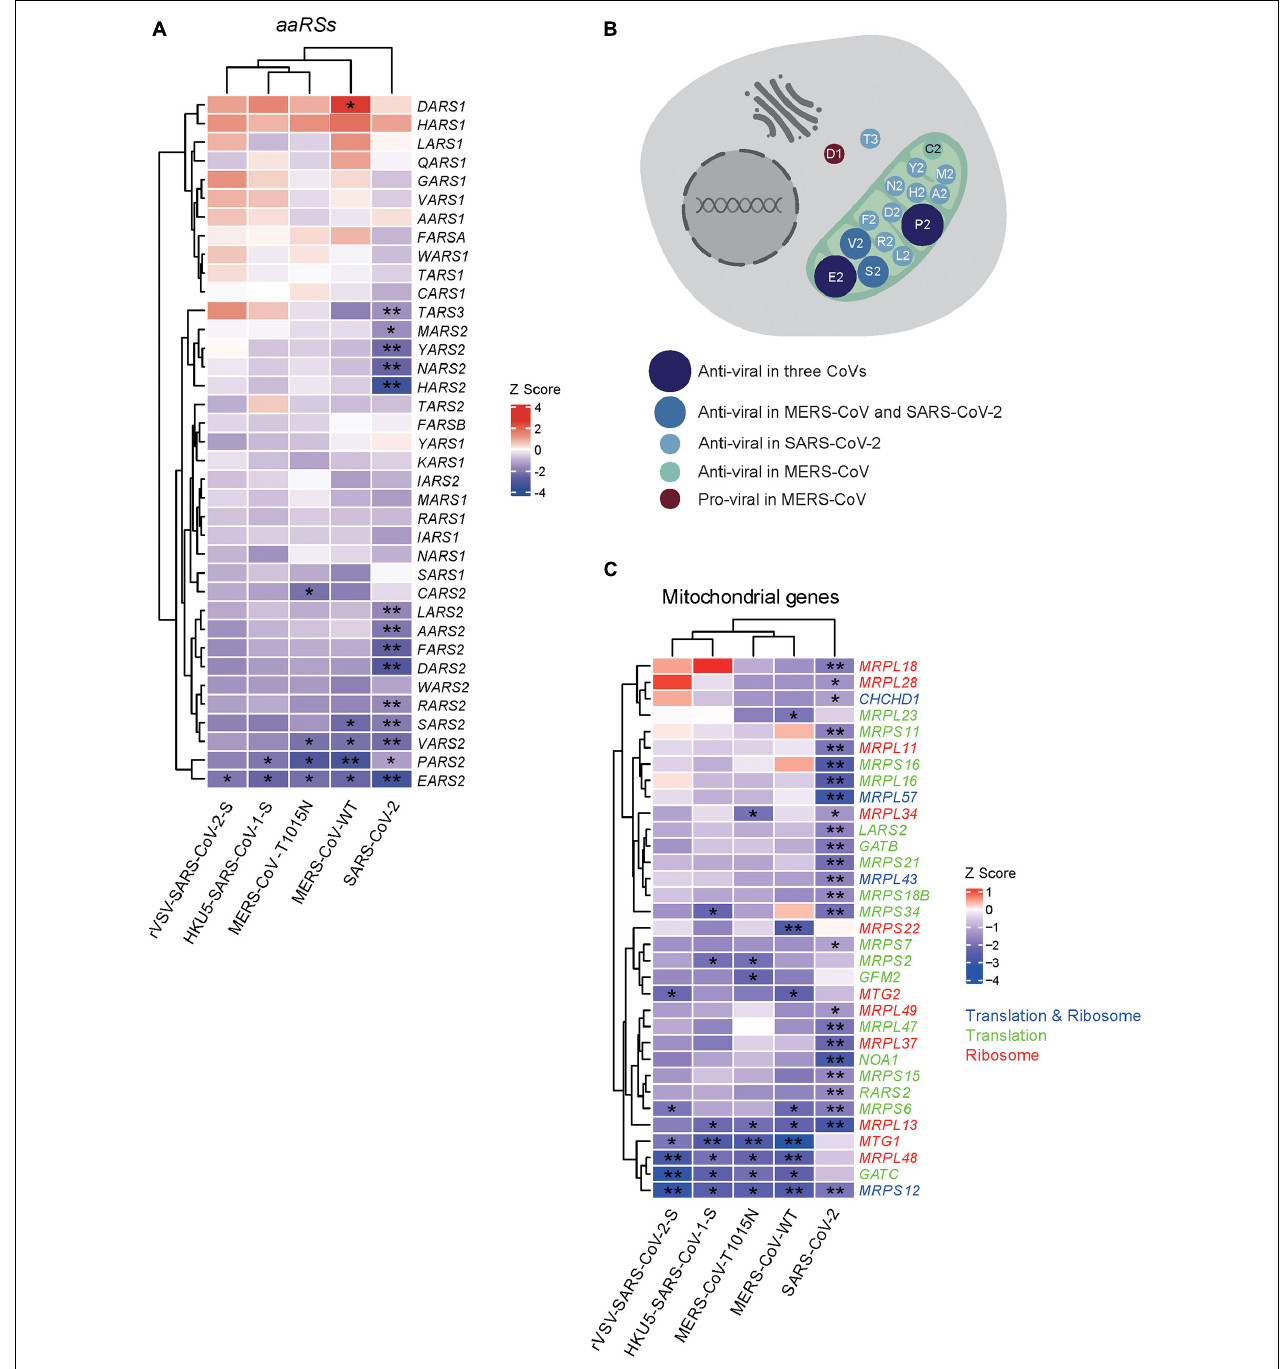
FIGURE 1 | Genome-wide CRISPR-based analysis of human aminoacyl-tRNA synthetases (aaRSs) upon infections with three coronaviruses (CoVs). (A) Z scores of aaRSs in Vero-E6 cells challenged with three CoVs, including SARS-CoV-2, MERS-CoV (WT), MERS-CoV-T1015N, HKU5-SARS-CoV-1-S, and rVSV-SARS-CoV-2-S, respectively. Transcriptional expressions of aaRSs based on a genome-wide CRISPR screening were clustered by their mean Z scores with red representing Z > 0 while blue representing Z < 0. * p < 0.05; ** p < 0.01 (vs. mock-infected cells). (B) Subcellular localization of aaRSs upon CoVs infections based on their Z scores, where the mitochondrion is shown in light green. (C) Z scores of mitochondrial translation- and ribosome-related genes in Vero-E6 cells challenged with different CoVs. Transcriptional expressions of translation- and ribosome-related genes (blue), translation-related genes (green), and ribosome-related genes (red) based on a genome-wide CRISPR screening were clustered by their mean Z scores with red representing Z > 0 while blue representing Z < 0. * p < 0.05; ** p < 0.01 (vs. mock-infected cells).